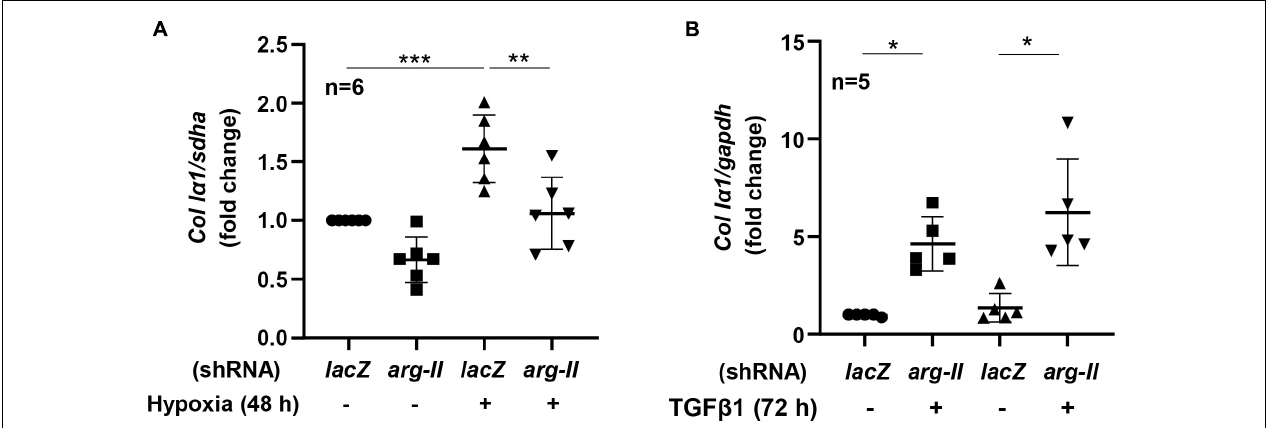
FIGURE 5 | Effects of Arg-II silencing and TGF β 1 on collagen I α 1 expression in HK2 cells. The cells were exposed either to (A) hypoxia (48 h) or stimulated with (B) TGF β 1 (5 ng/mL, 72 h) and collagen Ia1 gene (Col Ia1) was analyzed. Data are shown as mean ± SD. * P < 0.05, ** p < 0.01, and *** P < 0.001 between the indicated groups. ANOVA with Bonferroni post hoc test was